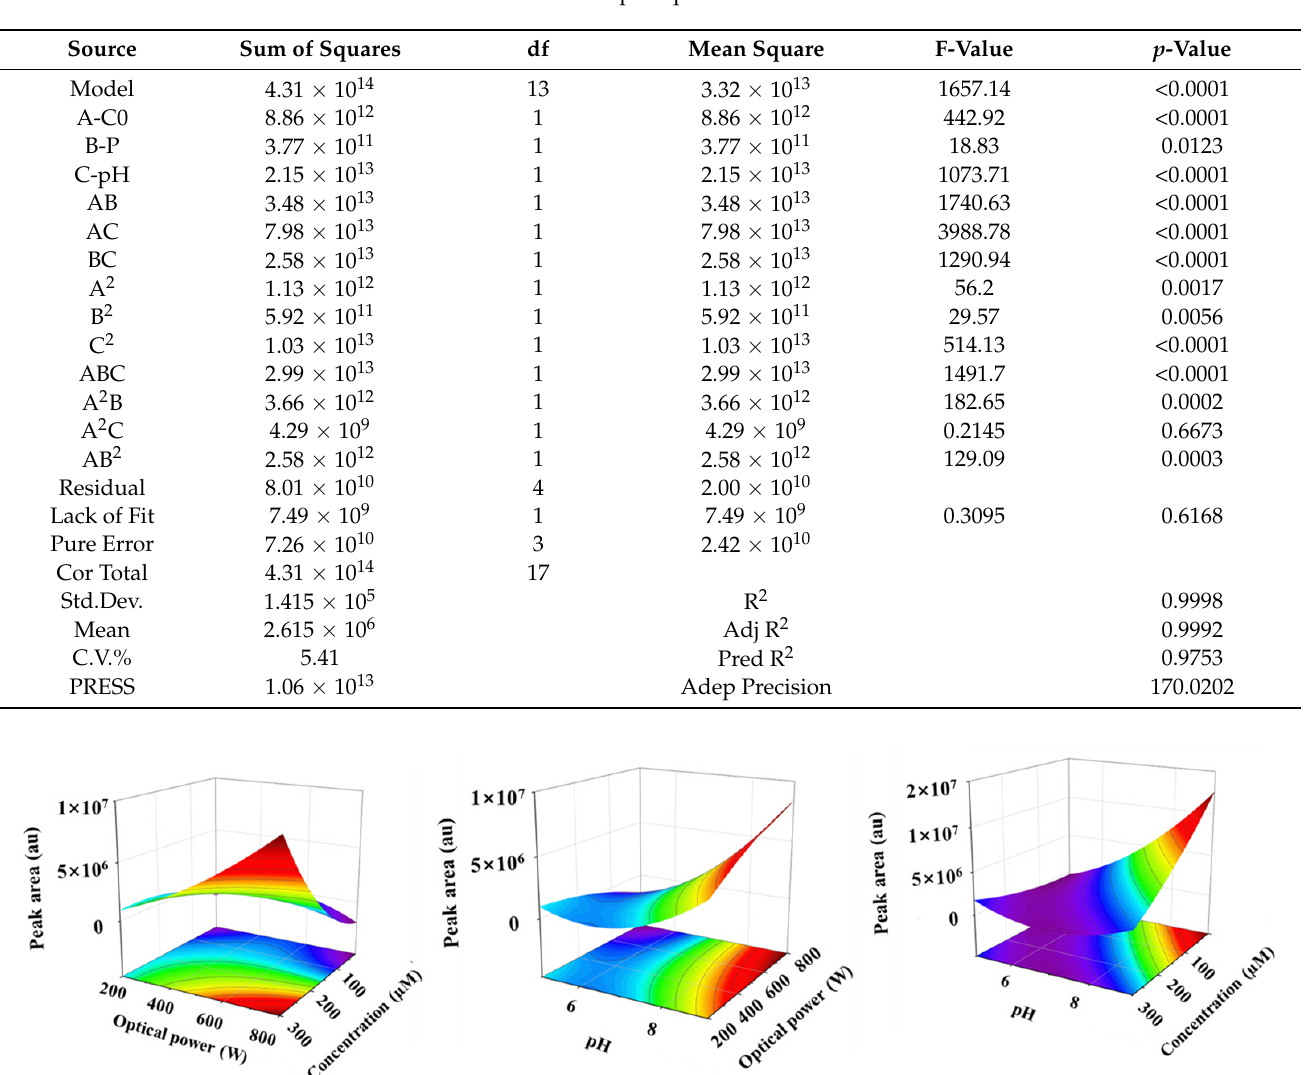
Table 2. ANOVA for the multiple equation.